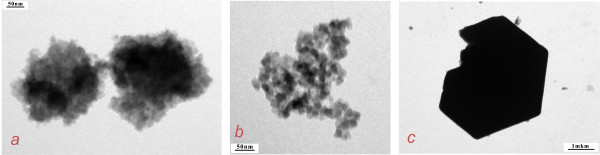
TEM images of Al0.25Si0.75O2+δ. TEM images of Al0.25Si0.75O2+δ synthesized using the following structure-directing agents: ammonium hydroxide (a), HMTA (b), and ammonium chloride (c).